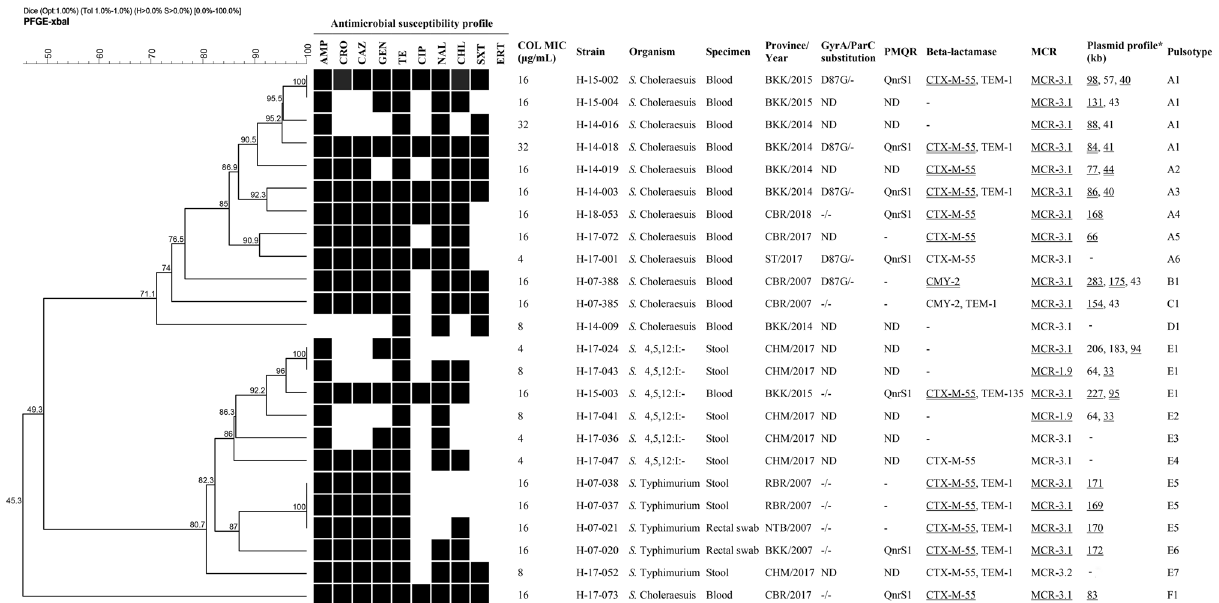
Figure 3. Dendrogram generated by PFGE- Xba I of 24 mcr -harbouring Salmonella isolates from humans in Thailand. Isolate summary information showing antimicrobial susceptibility profiles, colistin MIC, AMR mechanisms, plasmid profiles, and pulsotypes. Black squares represent isolates that were resistant to antimicrobial agents. Antimicrobial agents are abbreviated as follows: AMP ampicillin, CRO ceftriaxone, CAZ ceftazidime, GEN gentamicin, TE tetracycline, CIP ciprofloxacin, NAL nalidixic acid, CHL chloramphenicol, SXT trimethoprim-sulfamethoxazole, ERT ertapenem, COL colistin, BKK Bangkok, CBR Chonburi, ST Satun, CHM Chiang Mai, RBR Ratchaburi, NTB Nonthaburi, PMQR plasmid-mediated quinolone resistance, ND not determined; and -, not found. *Plasmid sizes and AMR mechanisms confirmed for the location on the plasmid by Southern blot and hybridisation are underlined by a single line or a double